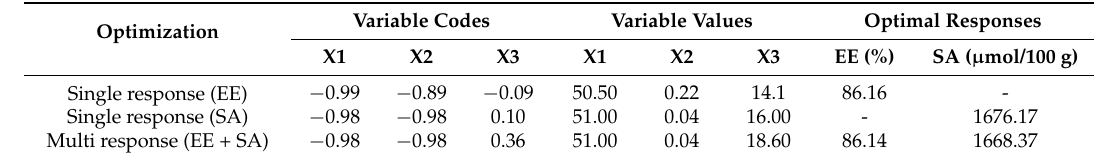
Table 3. Single and multi-response optimization of encapsulation parameters.